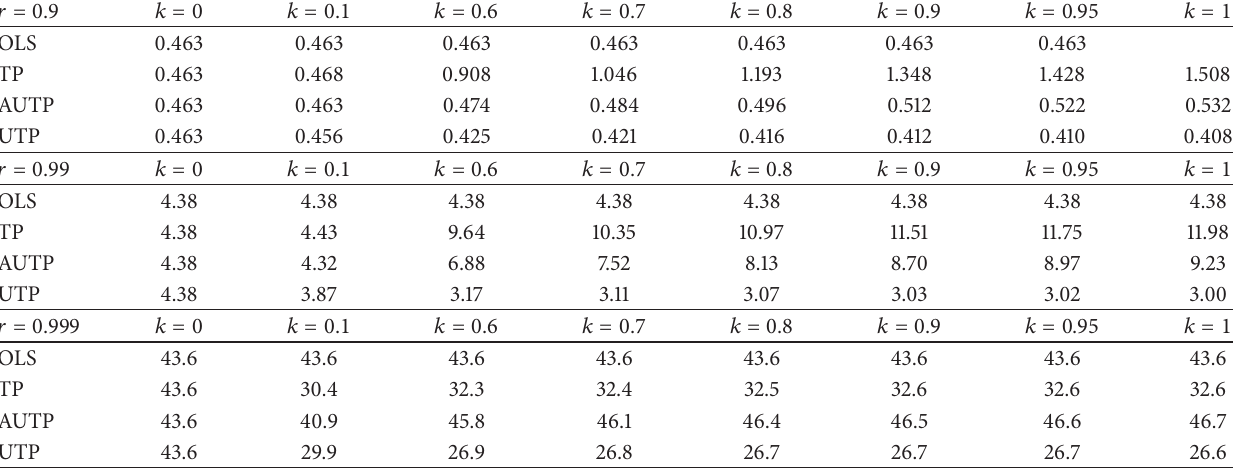
Table 6: Estimated MSE values of OLS, TP, AUTP, and UTP when 𝑛 = 25 , 𝑝 = 6 , and 𝜎 2 = 0.25